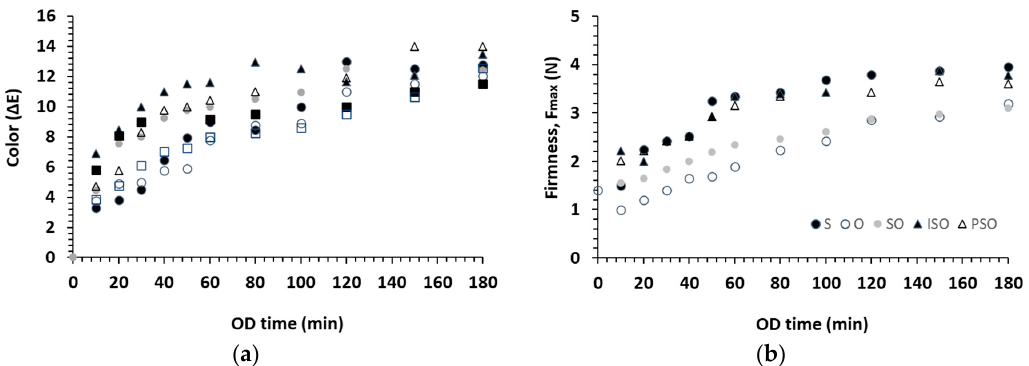
Figure 1. ( a ) Total color ( Δ E) and ( b ) firmness (F max ) changes during OD of tomatoes using different sweetener (S, O, SO, PSO, ISO) in the osmotic solution; OD solute concentration: 70°Brix; OD temperature: 85 °C. Points represent average values from the three measurements.